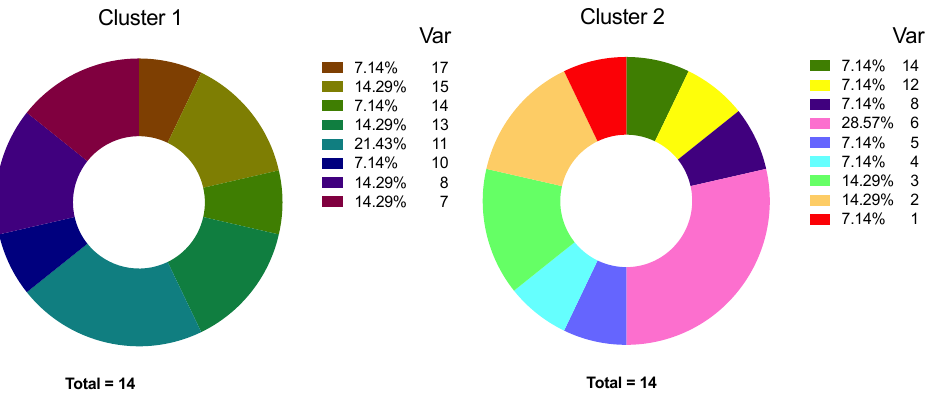
Figure 6. Interpersonal heterogeneity in the number of phenotypes in each of the patients belonging to the cluster 1 and 2. Var—variability of number of CTC phenotypes. N—number of patients.